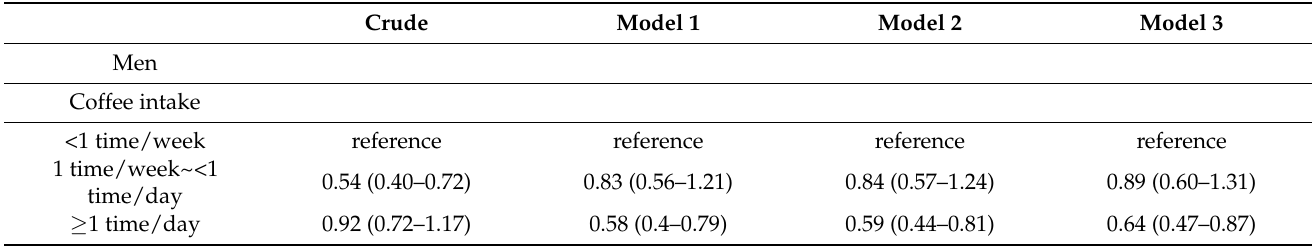
Table 2. Multivariable logistic regression for diabetes according to the frequency of intake of